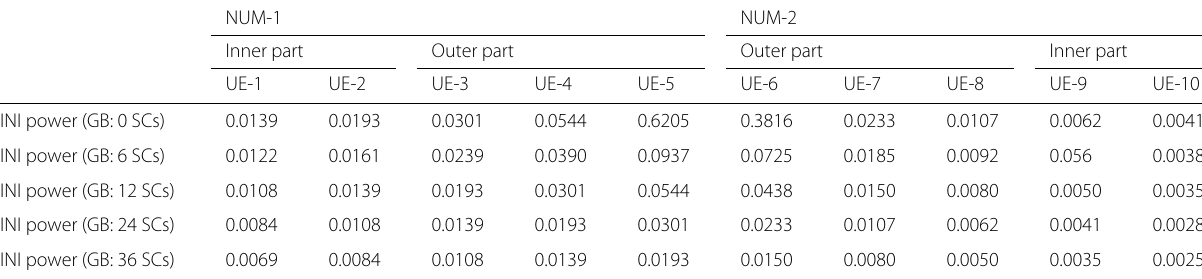
Table 2 Total INI powers on each user or subblock regarding Eq. (3) for different guard bands between two numerologies NUM-1 Outer part